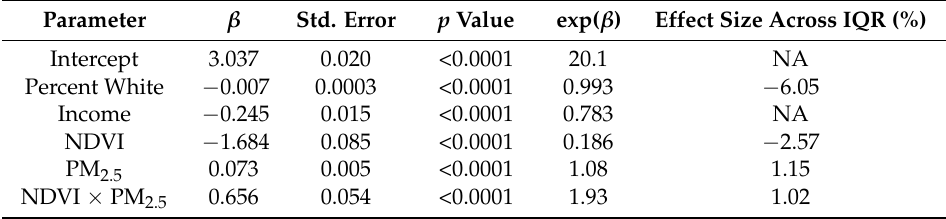
Table 2. Generalized linear model of NDVI, PM 2.5 and percent of students chronically absent in public schools in Massachusetts (USA) during the 2012–2013 academic year, controlling for race and testing for the interaction between NDVI and PM 2.5 . The effect size across the interquartile range (IQR) is shown for each continuous